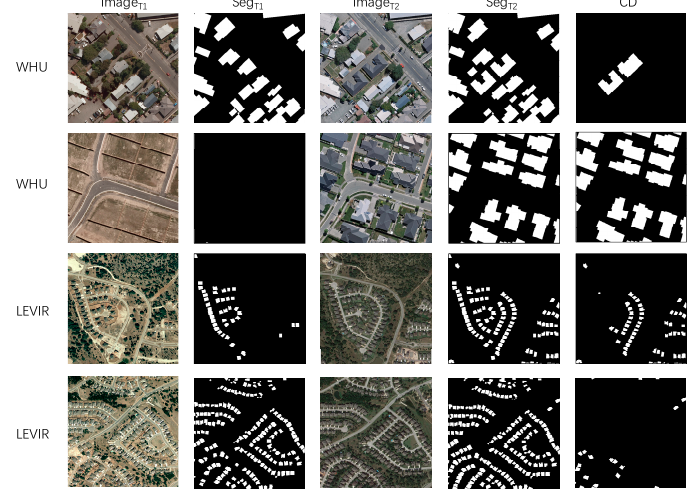
Figure 4. Examples of the WHU and LEVIR datasets.